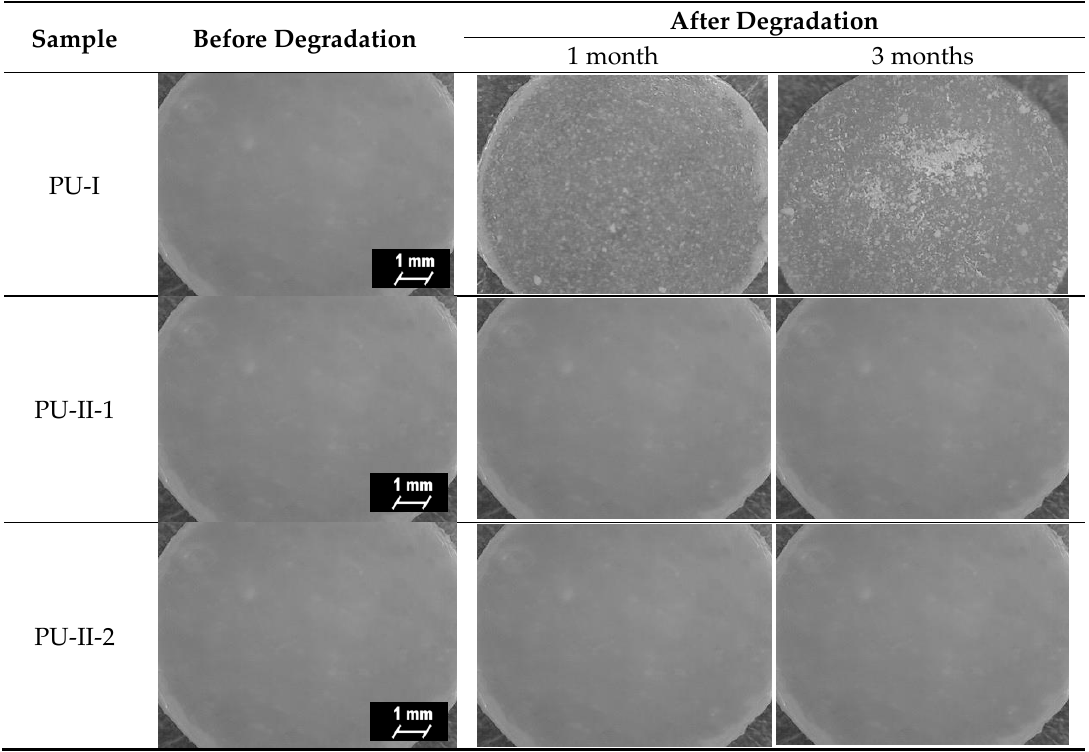
Figure 6. Microscopic images of the PUR surfaces before and after long-term interactions study performed in PBS.